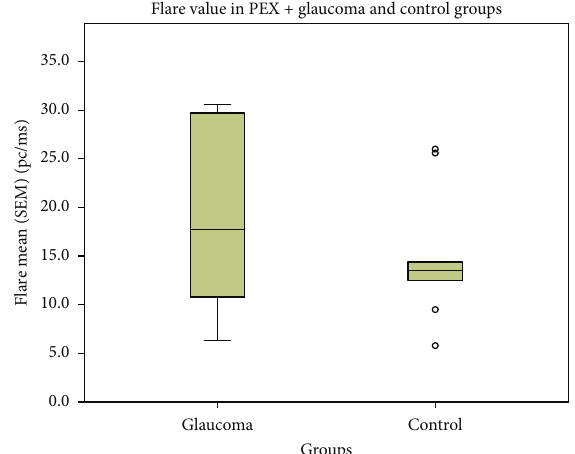
Figure 2: Flare value among (PEX − ) control and glaucoma groups. The mean values did not differ significantly; however, the glaucoma (PEX − ) group showed a higher aqueous humour flare tendency than the control group.